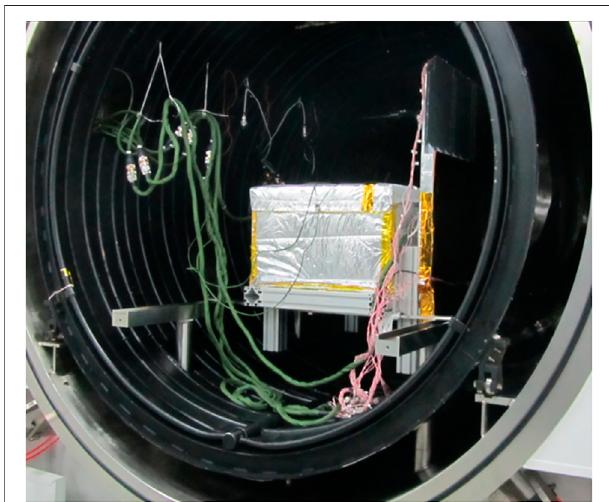
FIGURE 11 | Experiment setup.